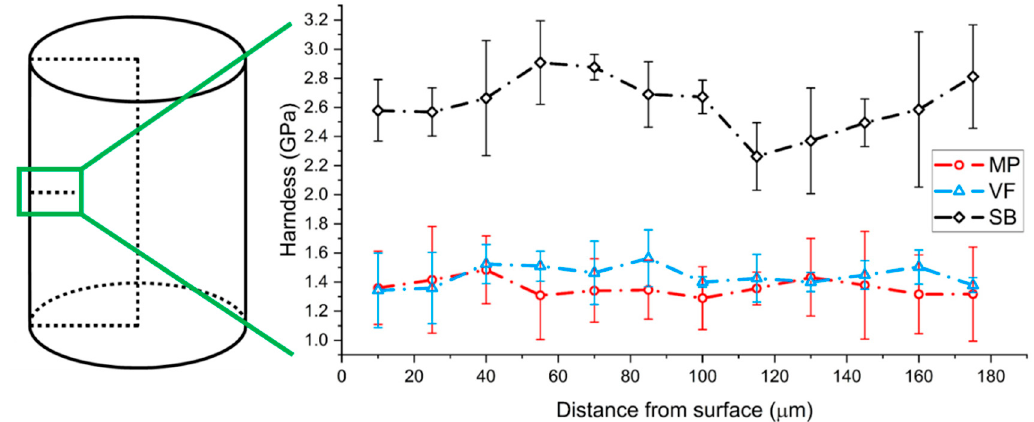
Figure 8. Nano-indentation profiles for the different surface conditions investigated; origin of distance corresponds to the surface of the specimen.